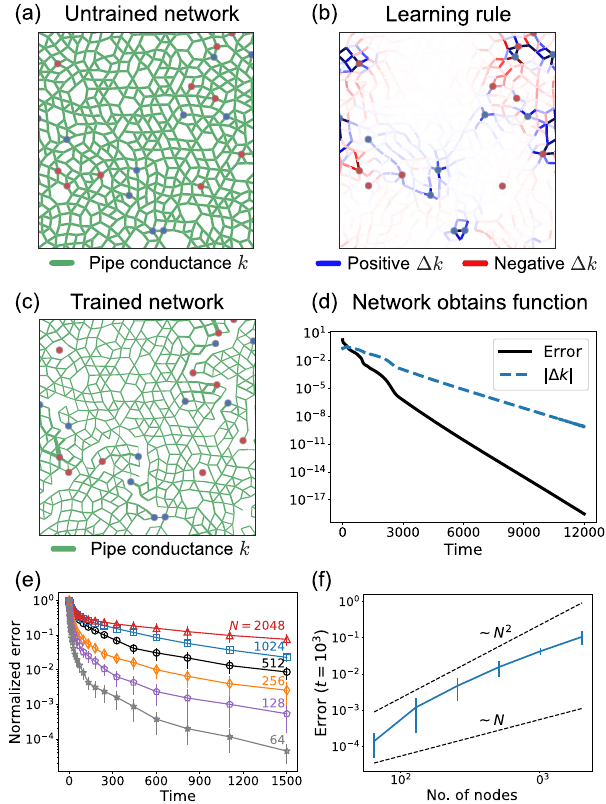
FIG. 2. Training flow networks with coupled learning. (a) An untrained disordered flow network with uniform conductance at all pipes k i ¼ 1 , as indicated by uniform thicknesses of the green edges. The ten red and blue nodes correspond to the source and target nodes with dot sizes indicating the magnitudes of the source pressures f P S g and desired target pressures f P T g . (b) In each step, conductance values are modified using Eq. (4), according to the difference in flow between the free and clamped states. This process is applied iteratively. (c) After training, the network conductance values, indicated by the thicknesses of the green edges, are considerably changed compared to the initial network shown in (a). (d) During training of a network ( N ¼ 512 nodes), the pressure values of the target nodes approach the desired values, as indicated by the exponentially shrinking error (black solid line). The desired target values f P T g are reached when the error is small; the modification of the conductance in each time step, Δ k (blue dashed line), vanishes exponentially as well. (e) We train multiple networks of different sizes N ¼ 64 – 2048 , and find that all can be trained successfully with coupled learning. Error bars indicate the variation with initial network and choice of sources and targets. In all cases, errors decay exponentially, yet larger networks converge slower. (f) Picking a certain time t ¼ 10 3 , we find that the error scales up with system size as a soft power between 1 and